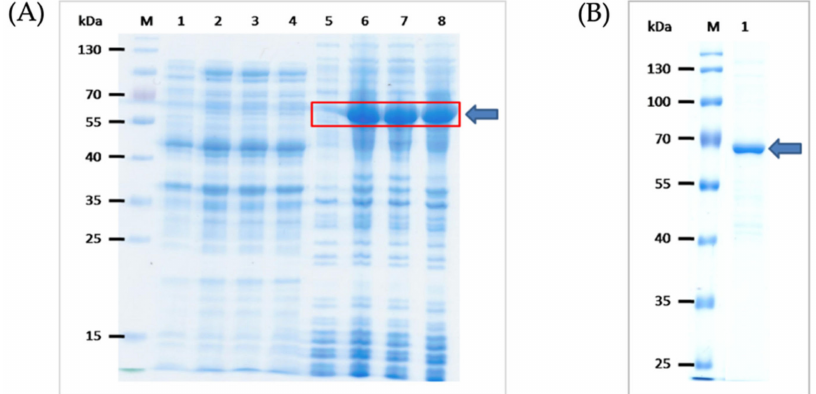
Figure 1. Recombinant GroEL preparation. ( A ) SDS-PAGE-separated proteins in the soluble and insoluble fractions of transformed BL21 (DE) E. coli carrying pET23b+ with inserted DNA coding for rGroEL of O. tsutsugamushi . Lanes 1 and 5, proteins in soluble and insoluble fractions of original BL21 (DE3) E. coli , respectively; lanes 2–4, proteins in the soluble fractions of transformed BL21 (DE3) E. coli , clones 1–3, respectively; lanes 6–8, proteins in the insoluble fractions of transformed BL21 (DE3) E. coli , clones 1–3, respectively. The recombinant protein was predominant in the E. coli insoluble fraction (red box and arrow). ( B ) Purified recombinant protein (arrow) from the transformed E. coli insoluble fraction solubilized in 1% SDS. Lanes M of ( A , B ) are protein molecular weight marker. Numbers on the left of both Figures are protein masses in kDa.